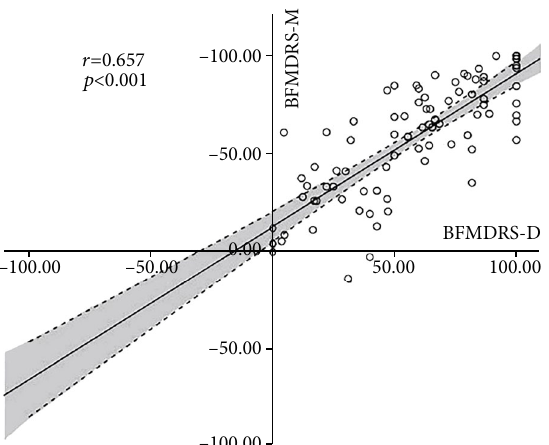
Figure 2: Correlation between relative improvement (%) in BFMDRS-M and BFMDRS-D at the last follow-up visit. There is a positive linear correlation between the relative improvement of BFMDRS-M and BFMDRS-D (Pearson r = 0 : 657 , p < 0 : 001 ). Dots: individual patient values; black solid line: linear regression line; area between the dotted lines: 95% con fi dence interval; BFMDRS: Burke – Fahn – Marsden Dystonia Rating Scale; BFMDRS-D: BFMDRS disability subscale; BFMDRS-M: BFMDRS movement